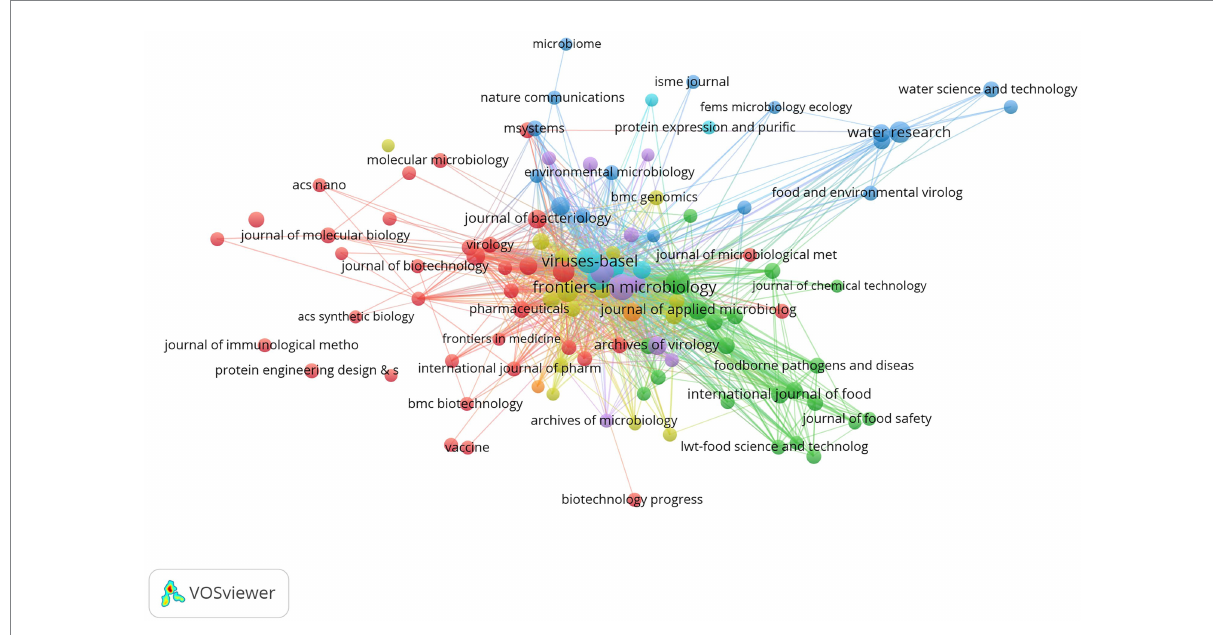
FIGURE 5 The network visualization of journals co-citation relationship.